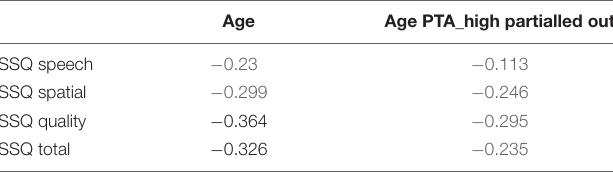
TABLE 3 | Spearman correlation coefficients ρ for results on SSQ scores (speech, spatial, quality, and total SSQ score) vs. age (first column).